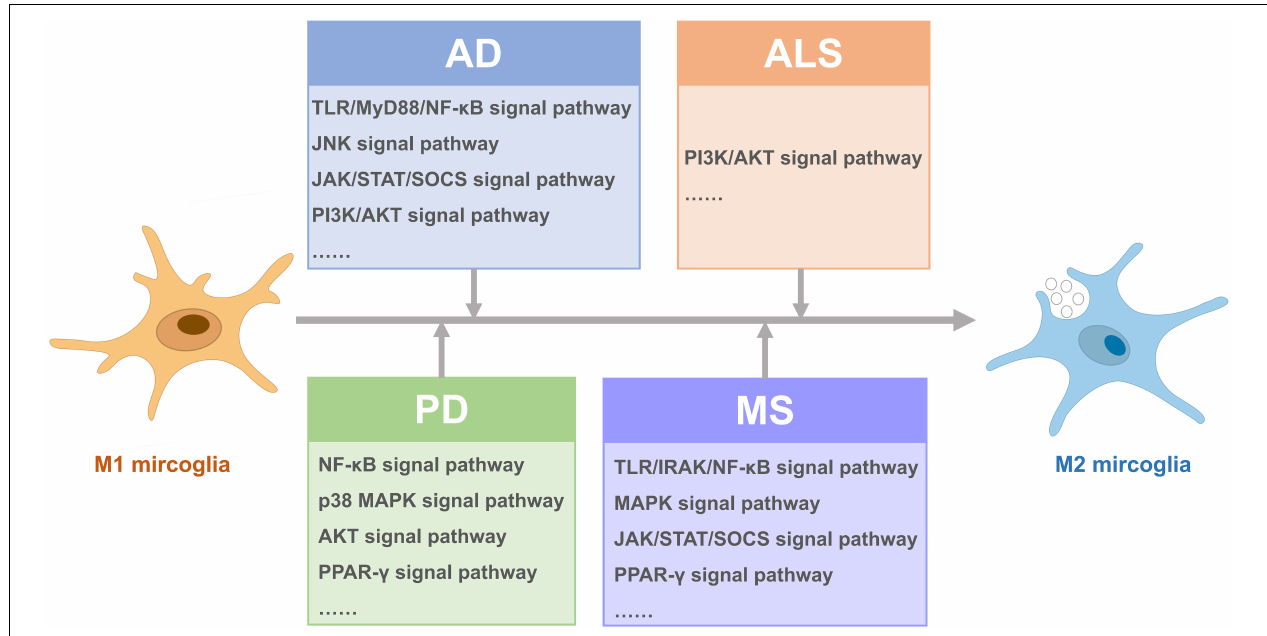
FIGURE 2 | Signal pathways activated for microglia polarization from M1 to M2 in different neurodegenerative